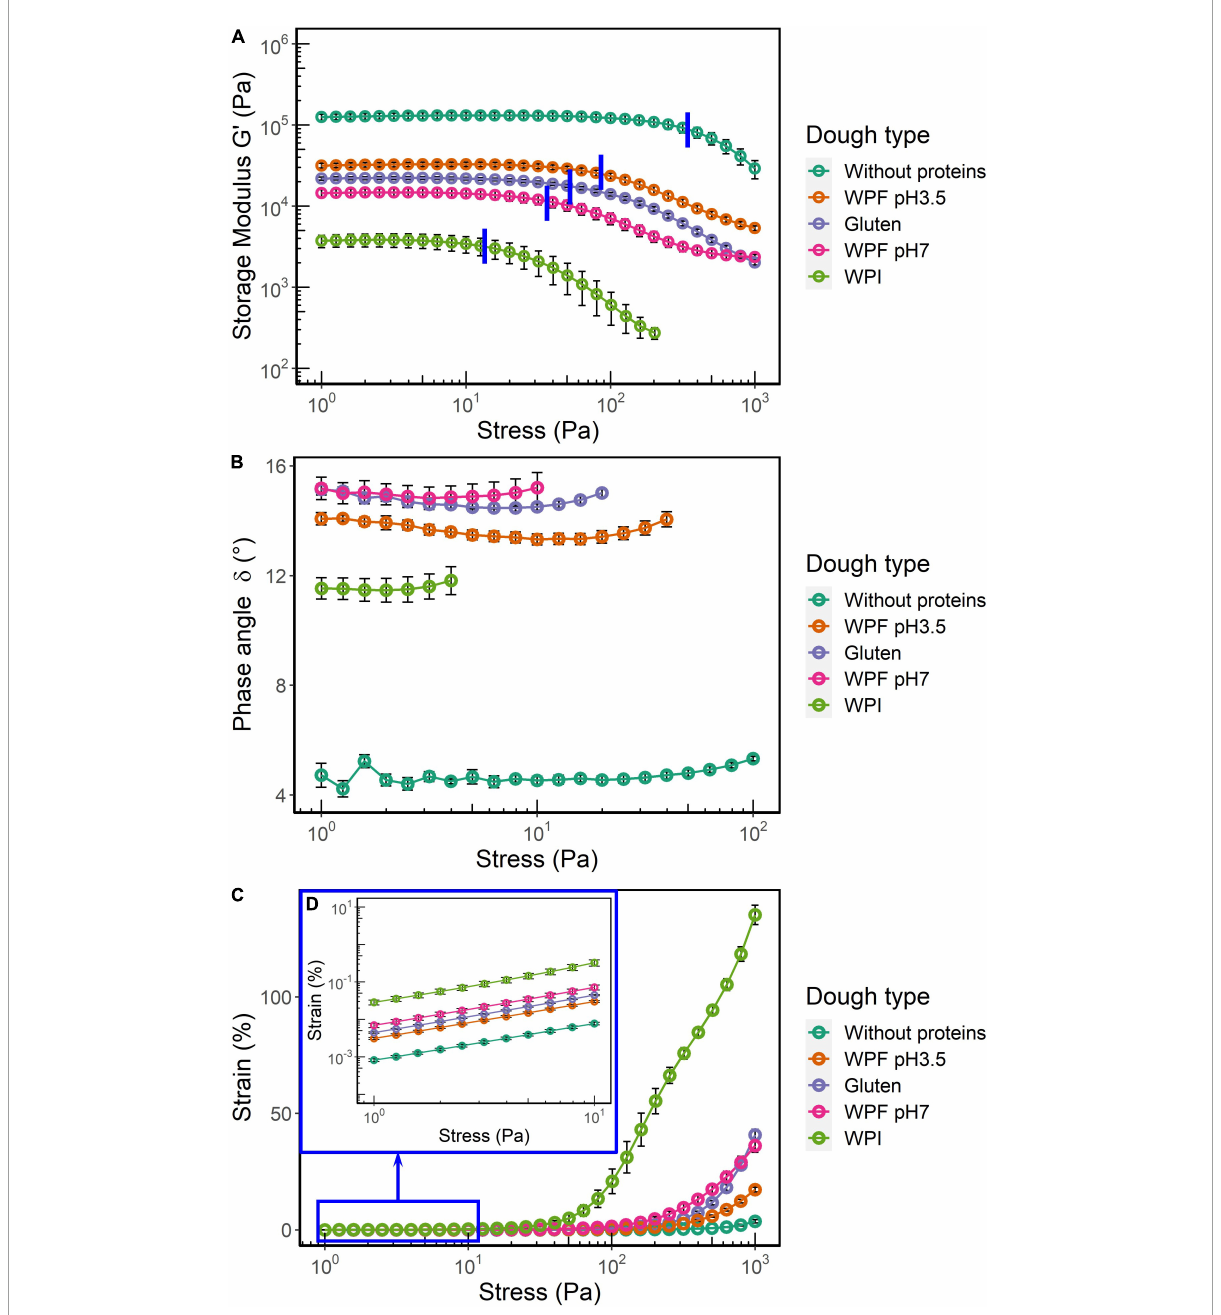
FIGURE3 Storage modulus (G’), phase angle ( δ ), and strain as functions of the applied shear stress. The error bars represent the standard error. (A) G’ over the range of stress values. The average values of LVRE were highlighted by blue lines. (B) δ within the LVR. (C) Strain over the test range of stress. (D) Inset for the data of strain when the range of applied stress was 1–10